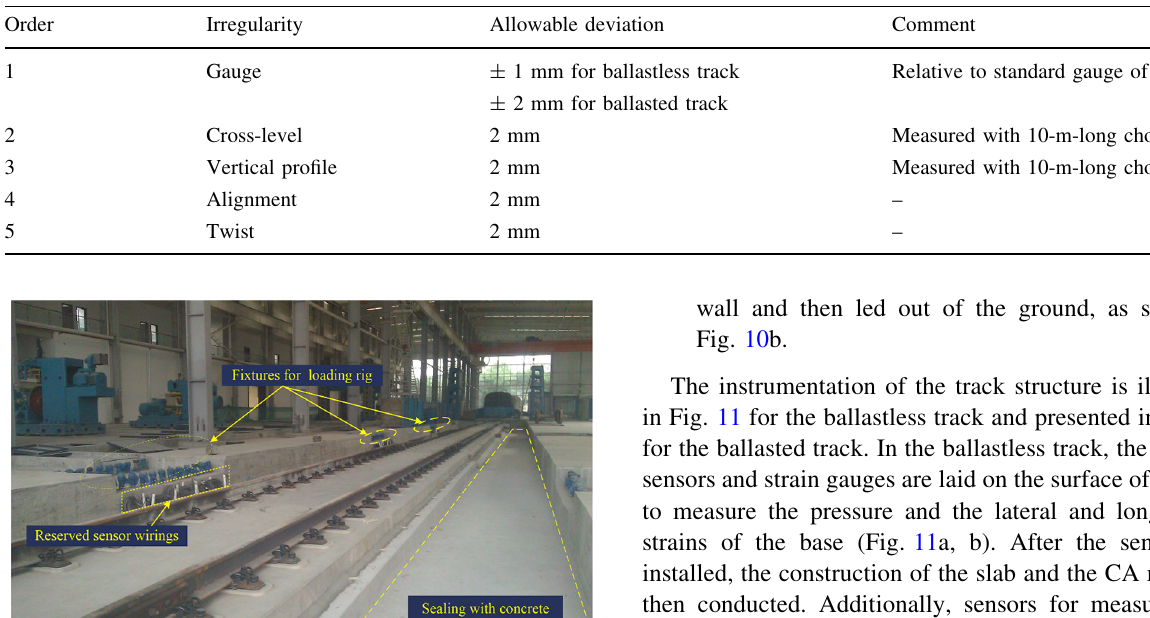
Table 3 Measurement of rail irregularity